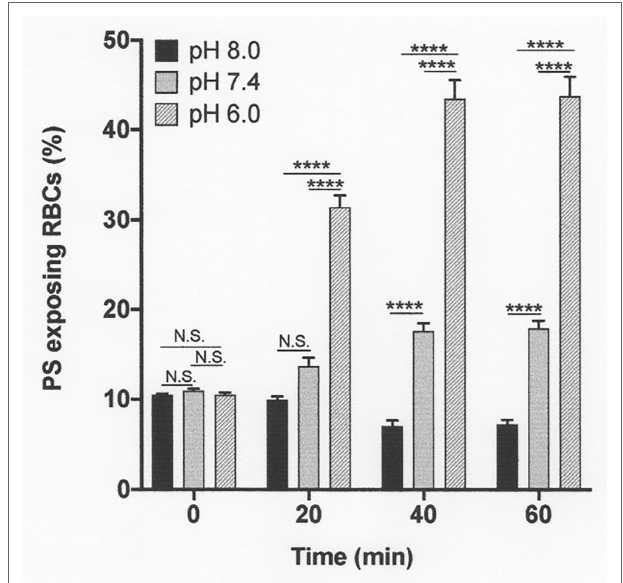
FIGURE 4 | The effect of urea on sickling of deoxygenated red cells from patients with SCA. Red cells (1% haematocrit, Hct) were incubated in Eschweiler tonometers at 37 o C, pH 7.4 and an osmolality of 290 mOsm.kg-1 for up to 80 min under fully deoxygenated conditions (0 mmHg oxygen) in the absence of urea (0 mM urea) or at three different urea concentrations (200, 600, and 900 mM). Red cell aliquots were then removed and fixed using 0.3% glutaraldehyde whilst maintaining the same urea concentration present during their incubation. Symbols represent means ± SEM, n = 4. * p < 0.05; *** p < 0.001; and **** p < 0.0001, comparing red cells in the absence of urea with those in its presence.